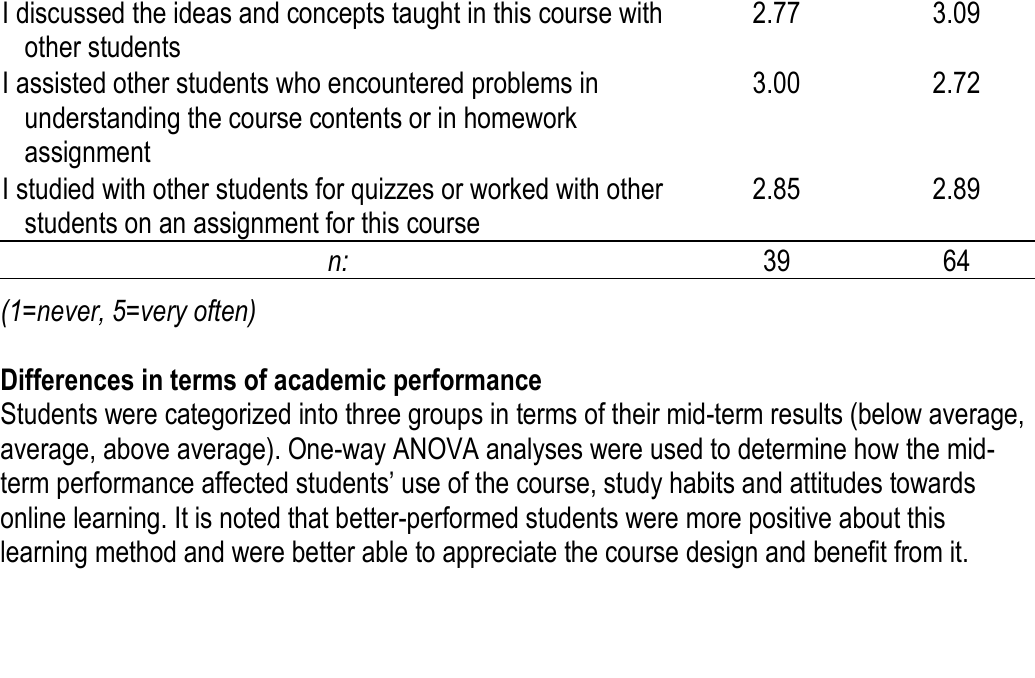
Table 6. Participation in collaboration activities